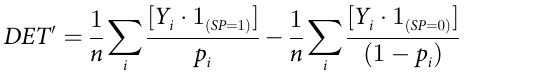
Table 3. Statistics of the Twitter accounts of nine authoritative public organizations.